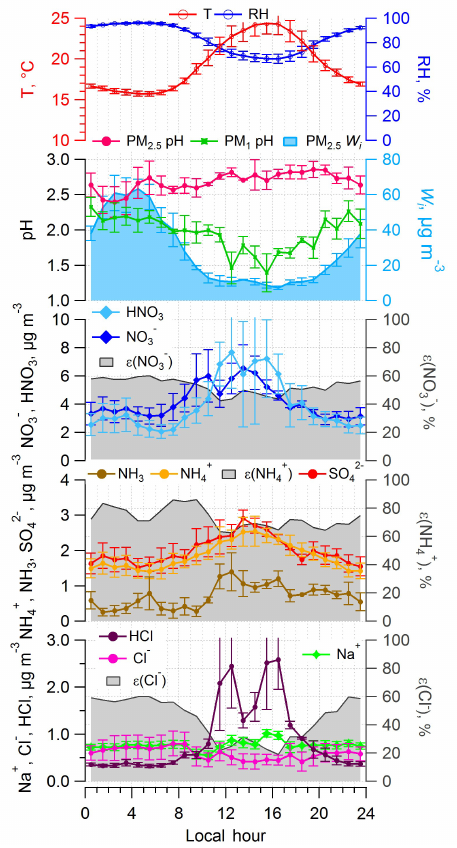
Figure 6. Diurnal profiles of predicted pH, LWC, and measured T , RH, particle- and gas-phase inorganic compound mass loadings (SO 2 − , NO − , NH + , HNO 3 , NH 3 ) , and particle-phase fractions 4 3 4 ) and ε (NH + )) . Data shown above are for the complete Cal- ( ε (NO − 3 4 Nex campaign, and particle-phase data are AMS PM 1 . Mean hourly averages are shown and standard errors are plotted as error bars.